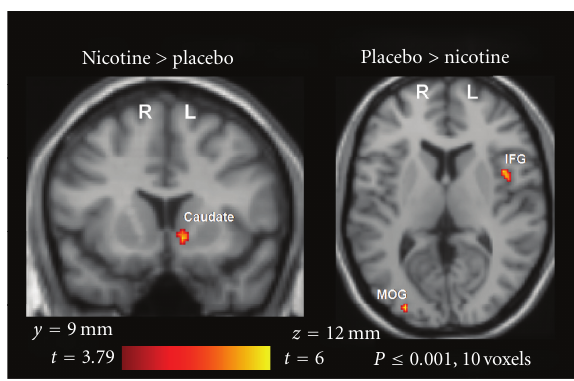
Figure 2: fMRI contrast of the main e ff ects of patch type. Across groups, activation (emotion morph > identity morph) was greater for nicotine versus placebo patch in left caudate ( x = − 10, y = 14, z = − 6), whereas greater activation was observed in left inferior frontal gyrus (IFG) ( x = − 42, y = 8, z = 8) and right middle occipital gyrus (MOG) ( x = 32, y = − 88, z = 4) for placebo versus nicotine patch.